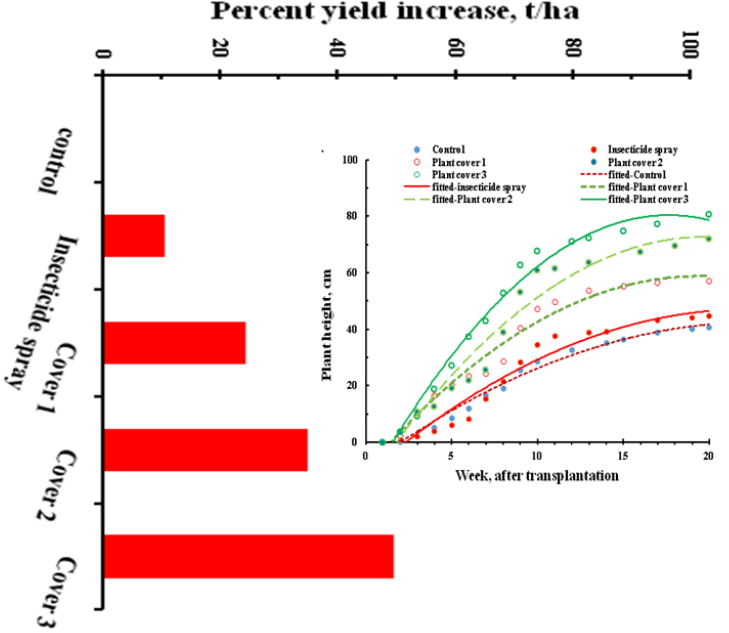
Figure 6. Relative plant growth rate and fresh fruit yield (t/ha) in chilli under interceptions against migrant viruliferous vectors.